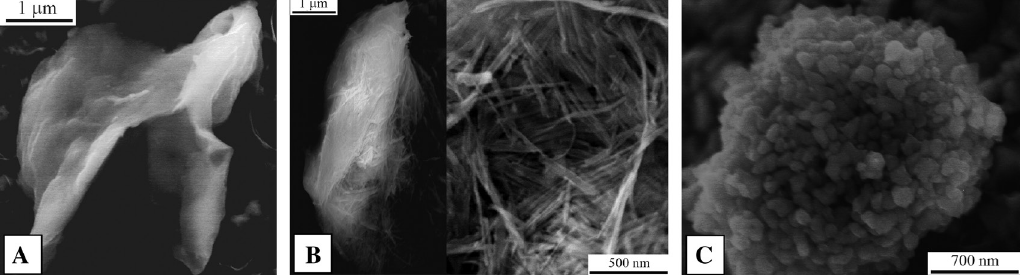
Figure 1 FESEM micrographs of the three fillers: (A) Cloisite ® 15A; (B) Sepiolite, with a high-magnification image of the needles; (C) α